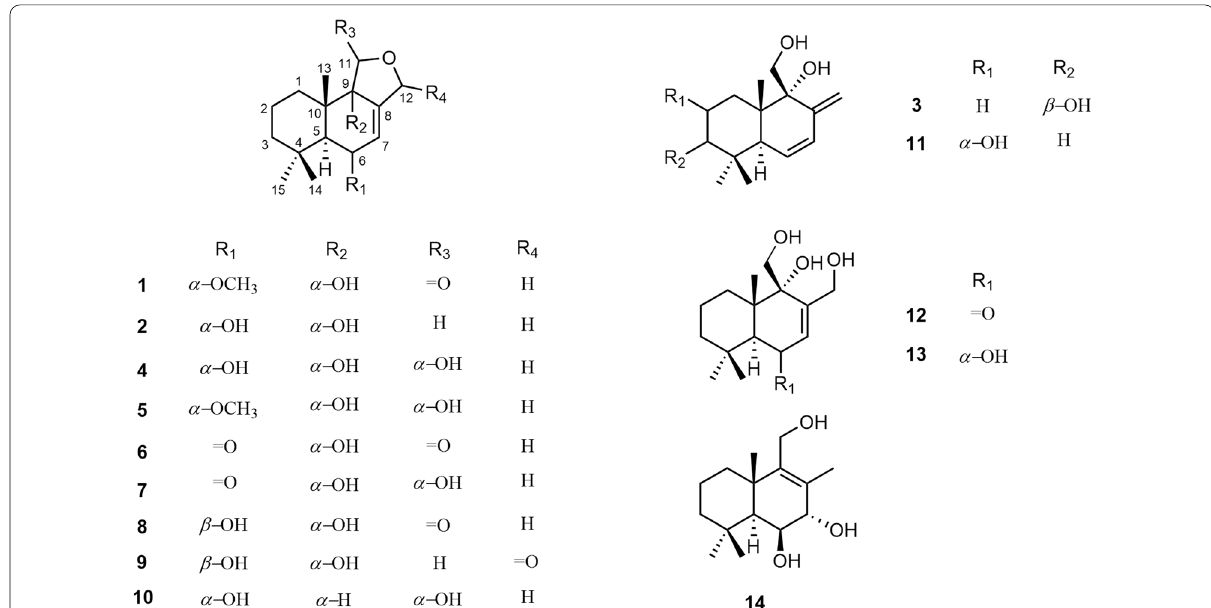
Fig. 1 Chemical structures of compounds